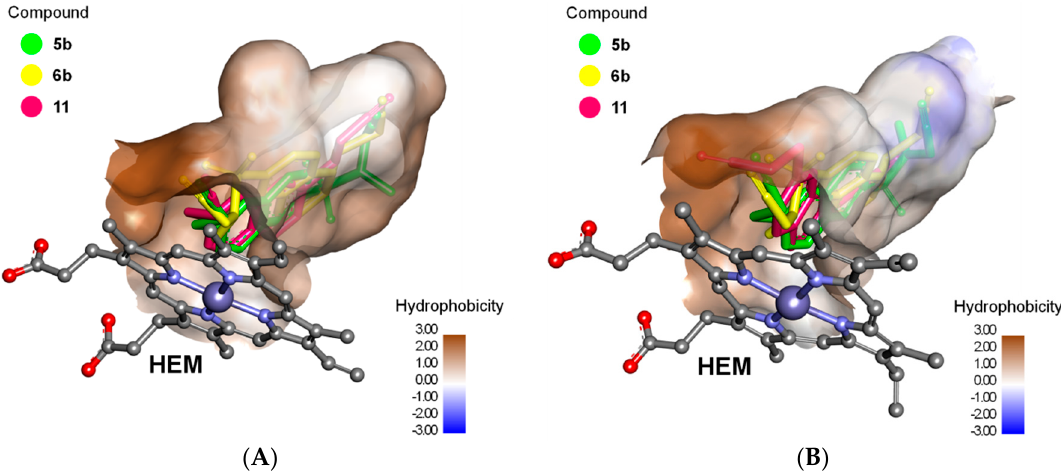
Figure 3. The superposition of compounds 5b , 6b, and 11 inside the active site’s cavity of human CYP1A1 ( A ) and CYP1B1 ( B ).